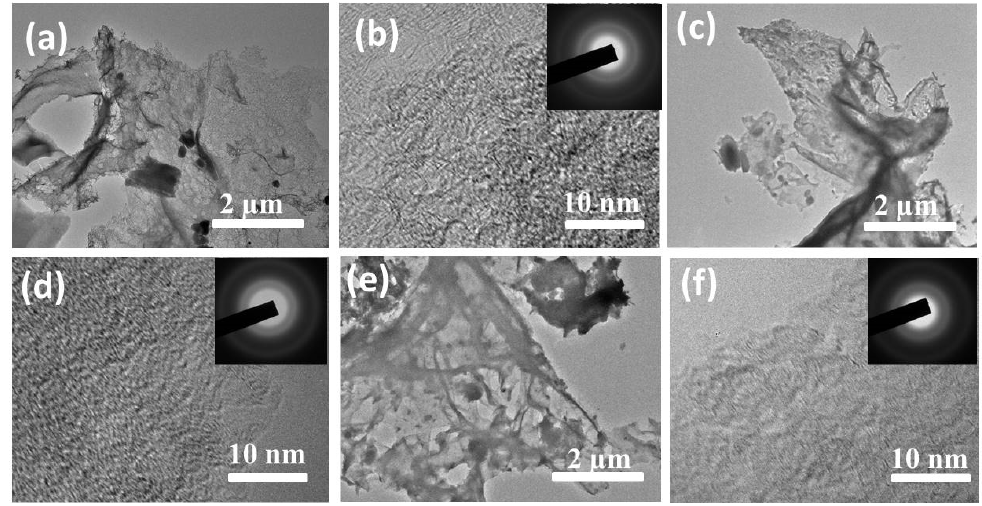
Figure 2. TEM images of ( a , b ) HPC-700, ( c , d ) HPC-800, and ( e , f ) HPC-900 (the inset is the corre- sponding SAED images).